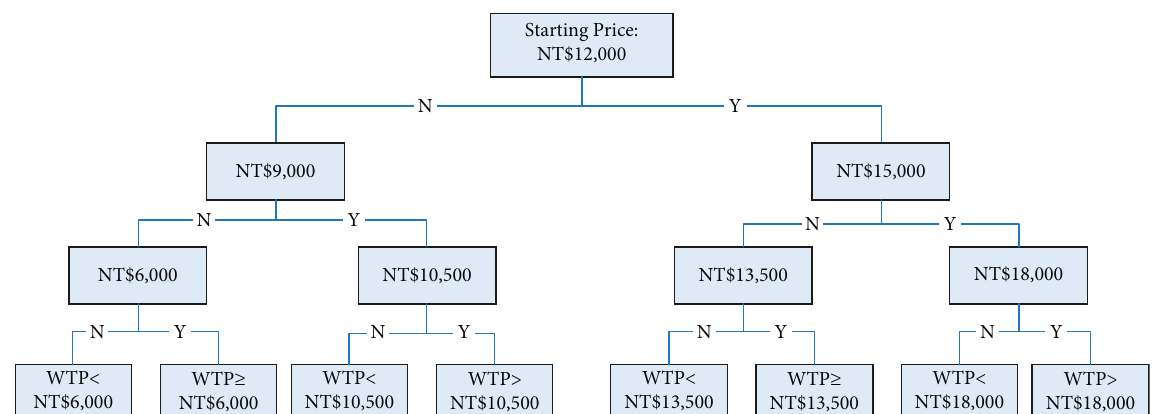
Figure 2: Schematic illustration of WTP. Y means willing to pay; N means not willing to pay.